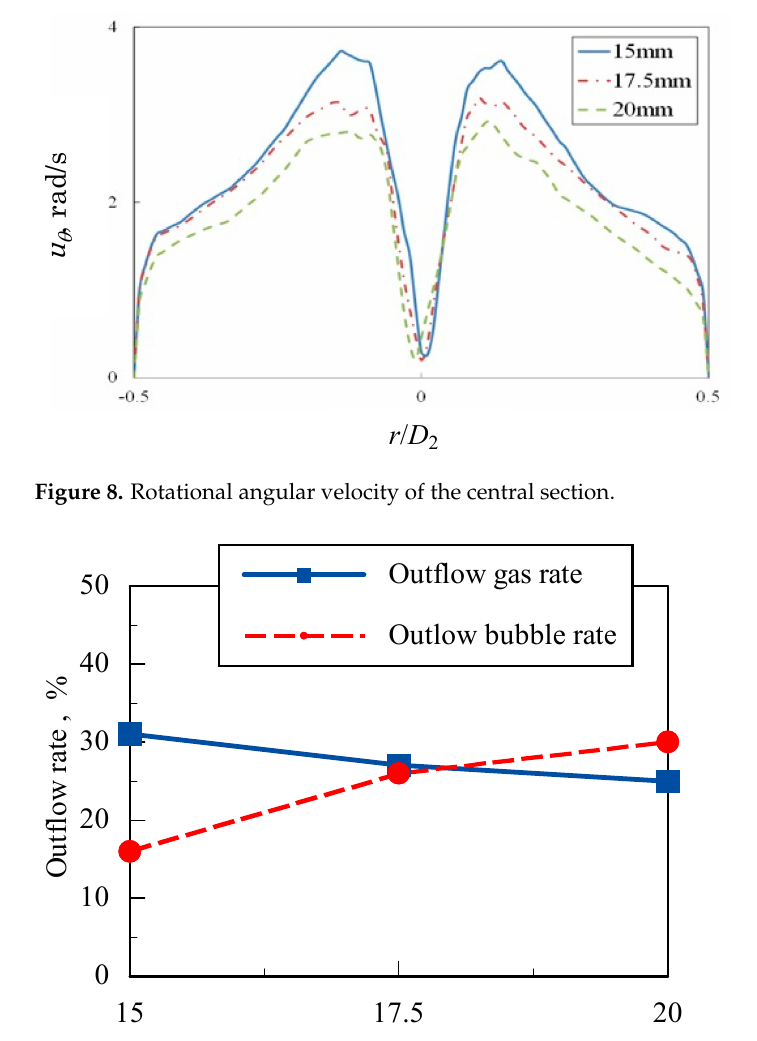
Figure 7. Volume fraction contour of the central section.